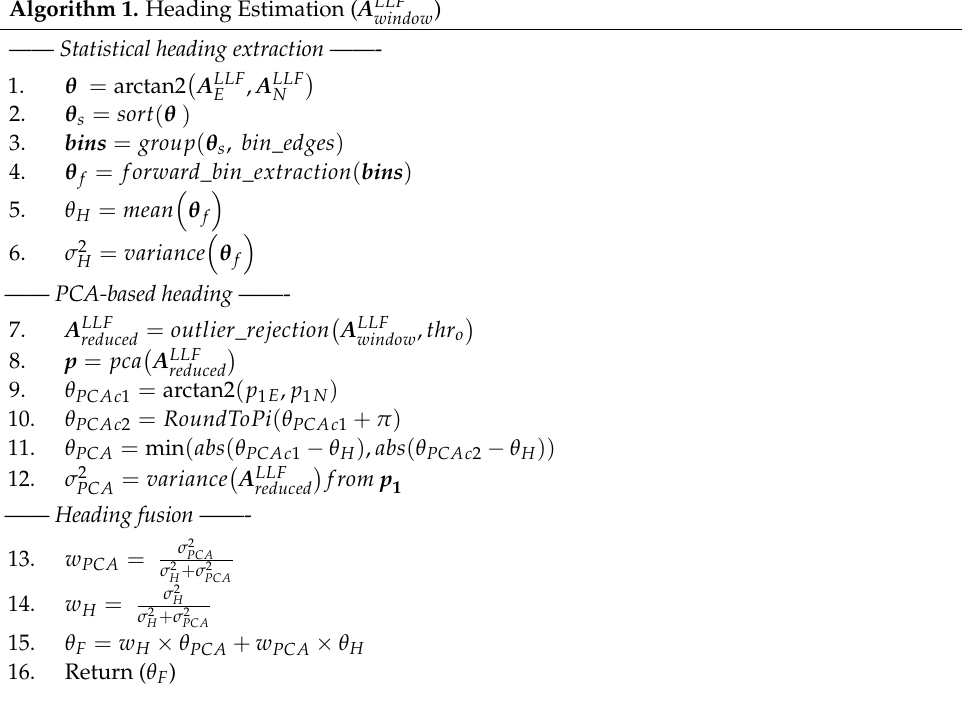
Figure 17. Heading estimation block diagram. Algorithm 1. Heading Estimation ( A LLF window